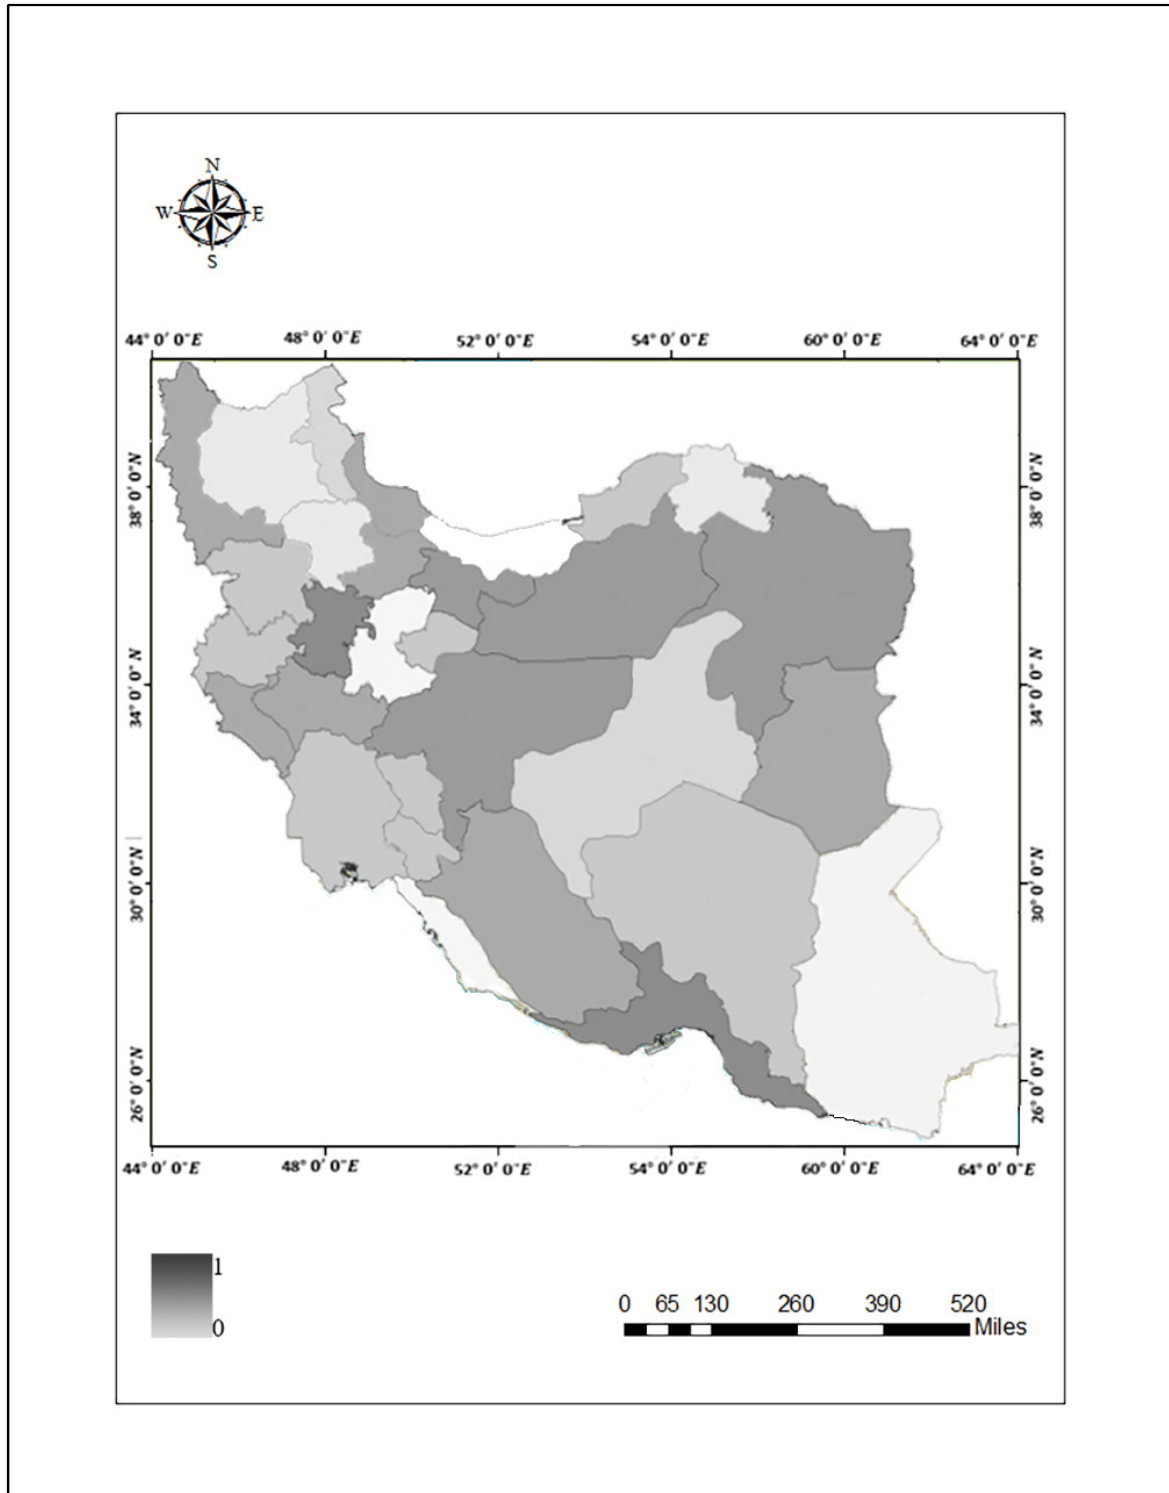
Figure 7. Hazard map of Iran using the Drought Severity Index calculated by using NOAA/AVHRR satellite data (1986–2016).